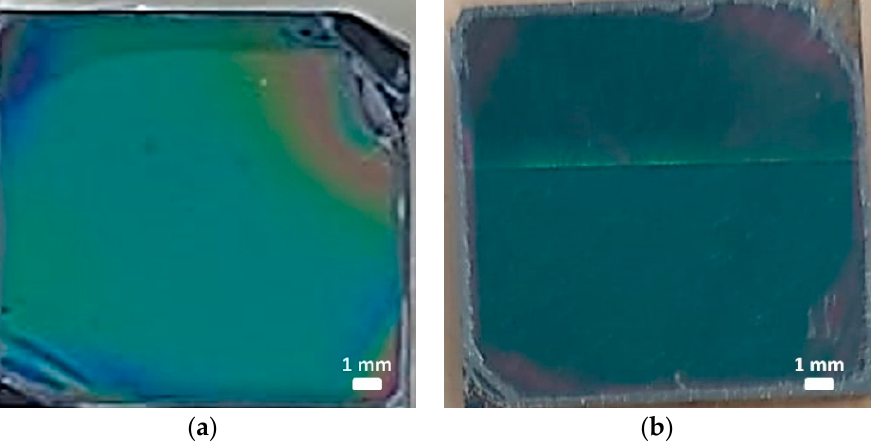
Figure 2. Optical images of fabricated P123-templated mesoporous TiO 2 layers. ( a ) Monolayer. ( b ) Tri-layer. The size of each sample shown in these pictures is 15 × 15 mm 2 .